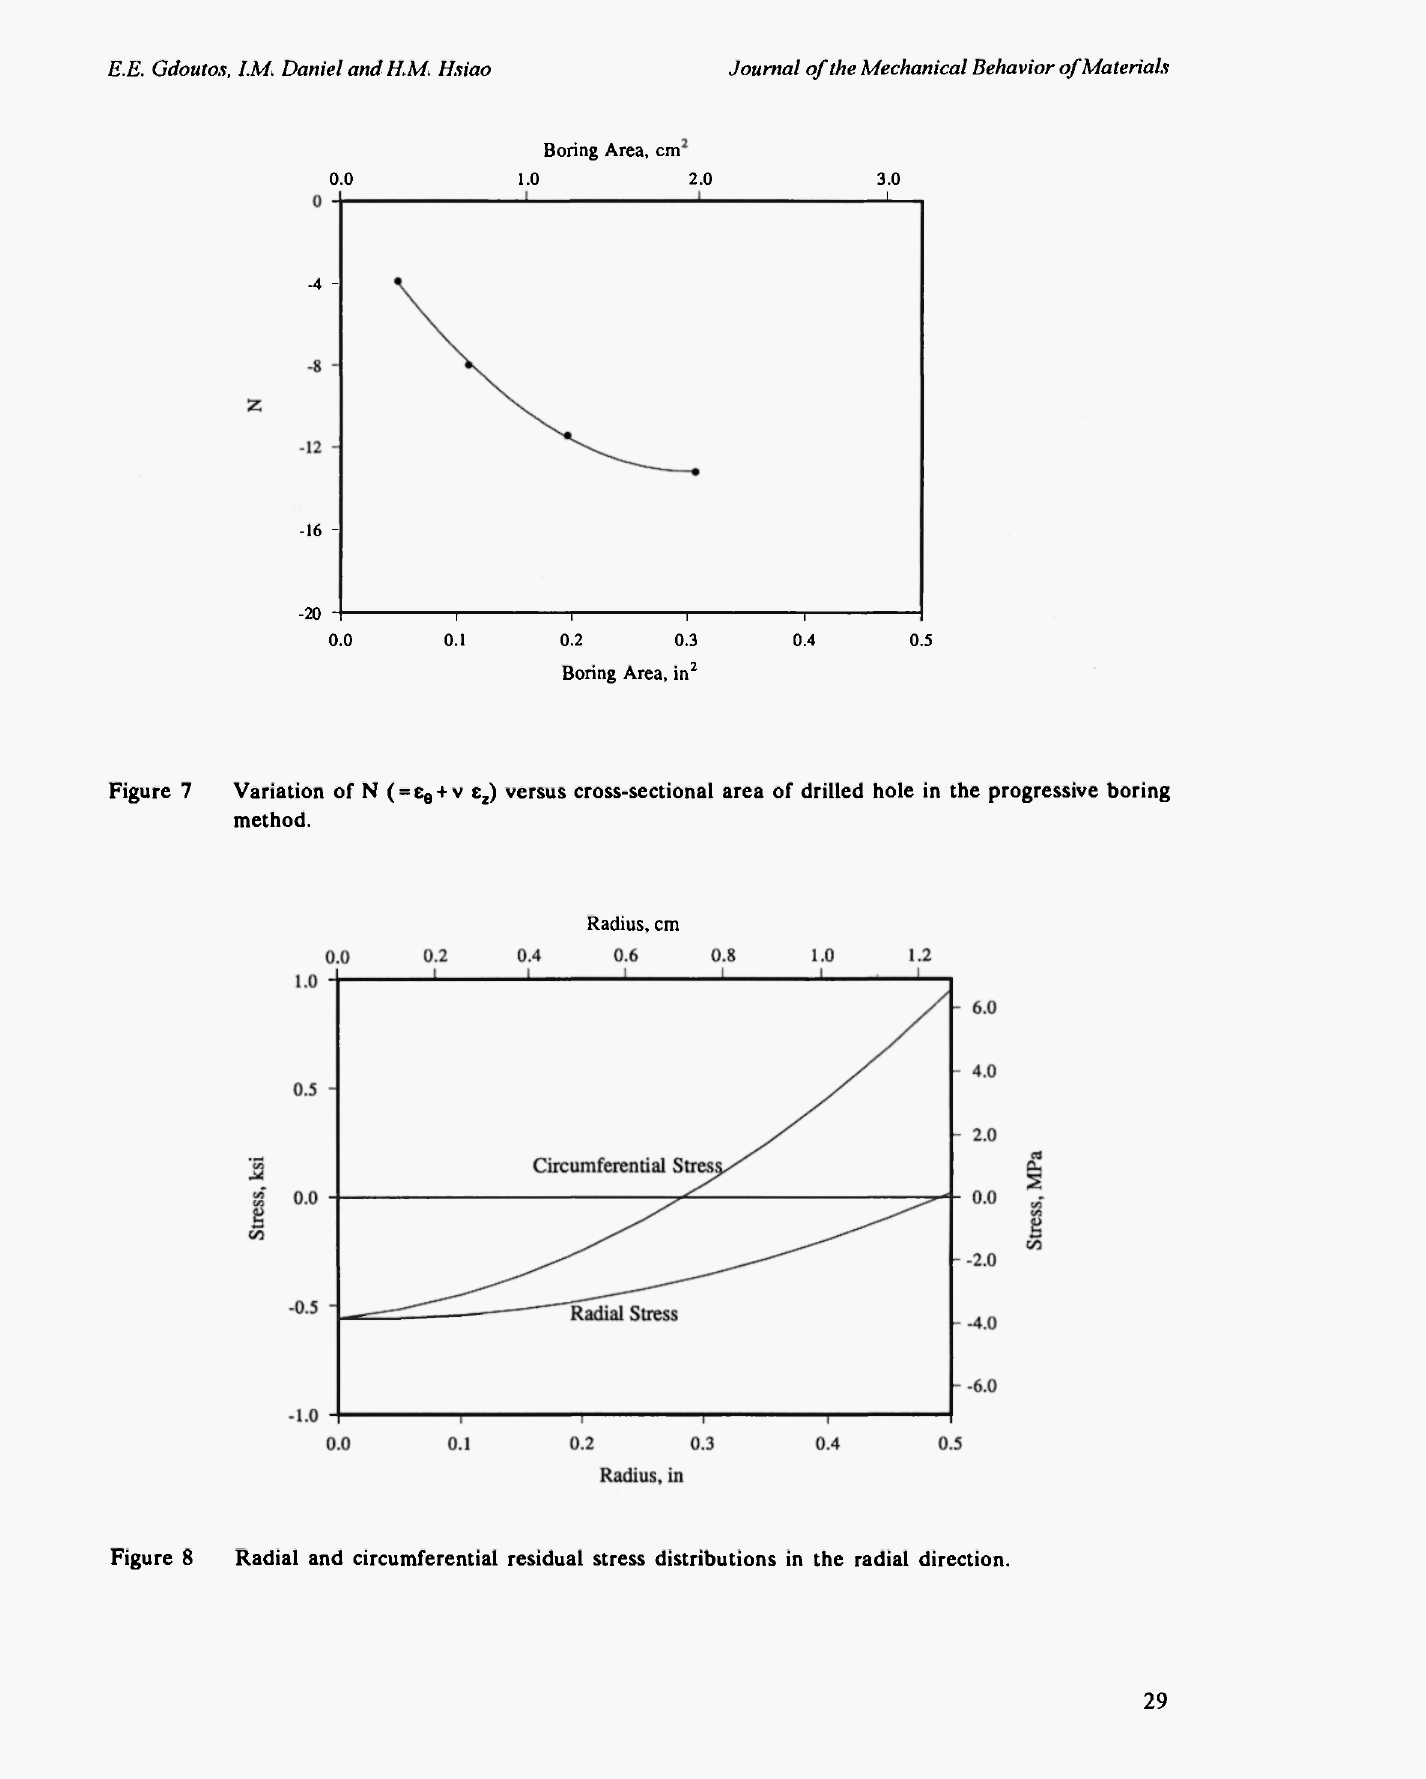
Figure 7 Variation of Ν ( = ε β + ν ε ζ ) versus cross-sectional area of drilled hole in the progressive boring method.